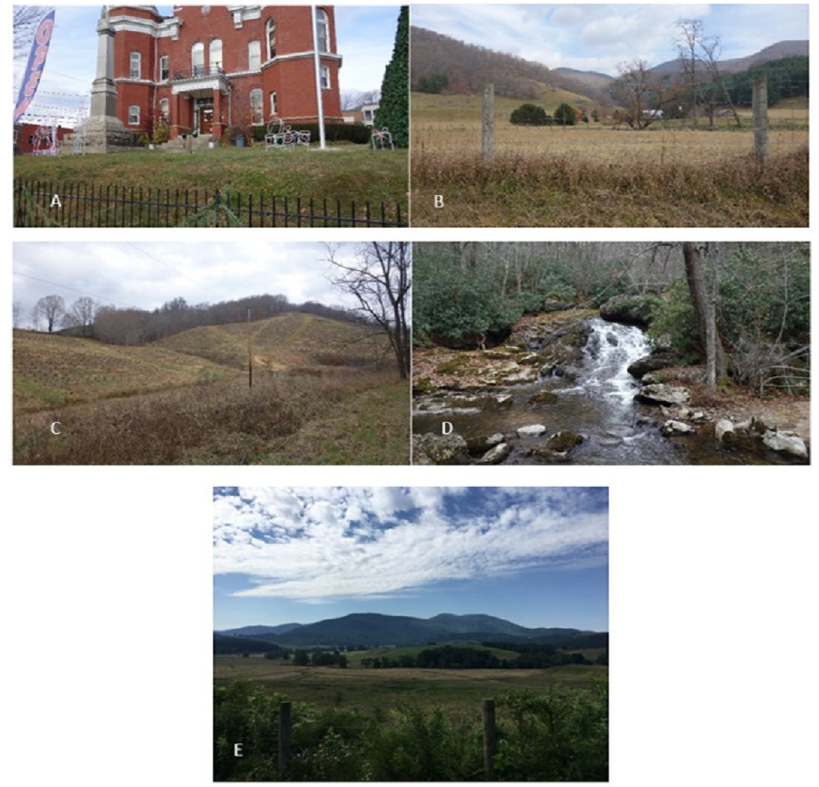
Figure 8. Landscape examples within Grayson County across the range of geodiversity classes. ( A )—Very Low (1), Land around Independence 1908 Courthouse; ( B )—Low (2), Open field in the foreground along Saddle Ridge Road; ( C )—Medium (3) Hilly farm field; ( D )—High (4) Waterfall along Fox Creek; ( E )—Very High (5), The peak on top of Point Lookout Mountain. Confusion over spatial scale also applies to the perception of geosystem services.